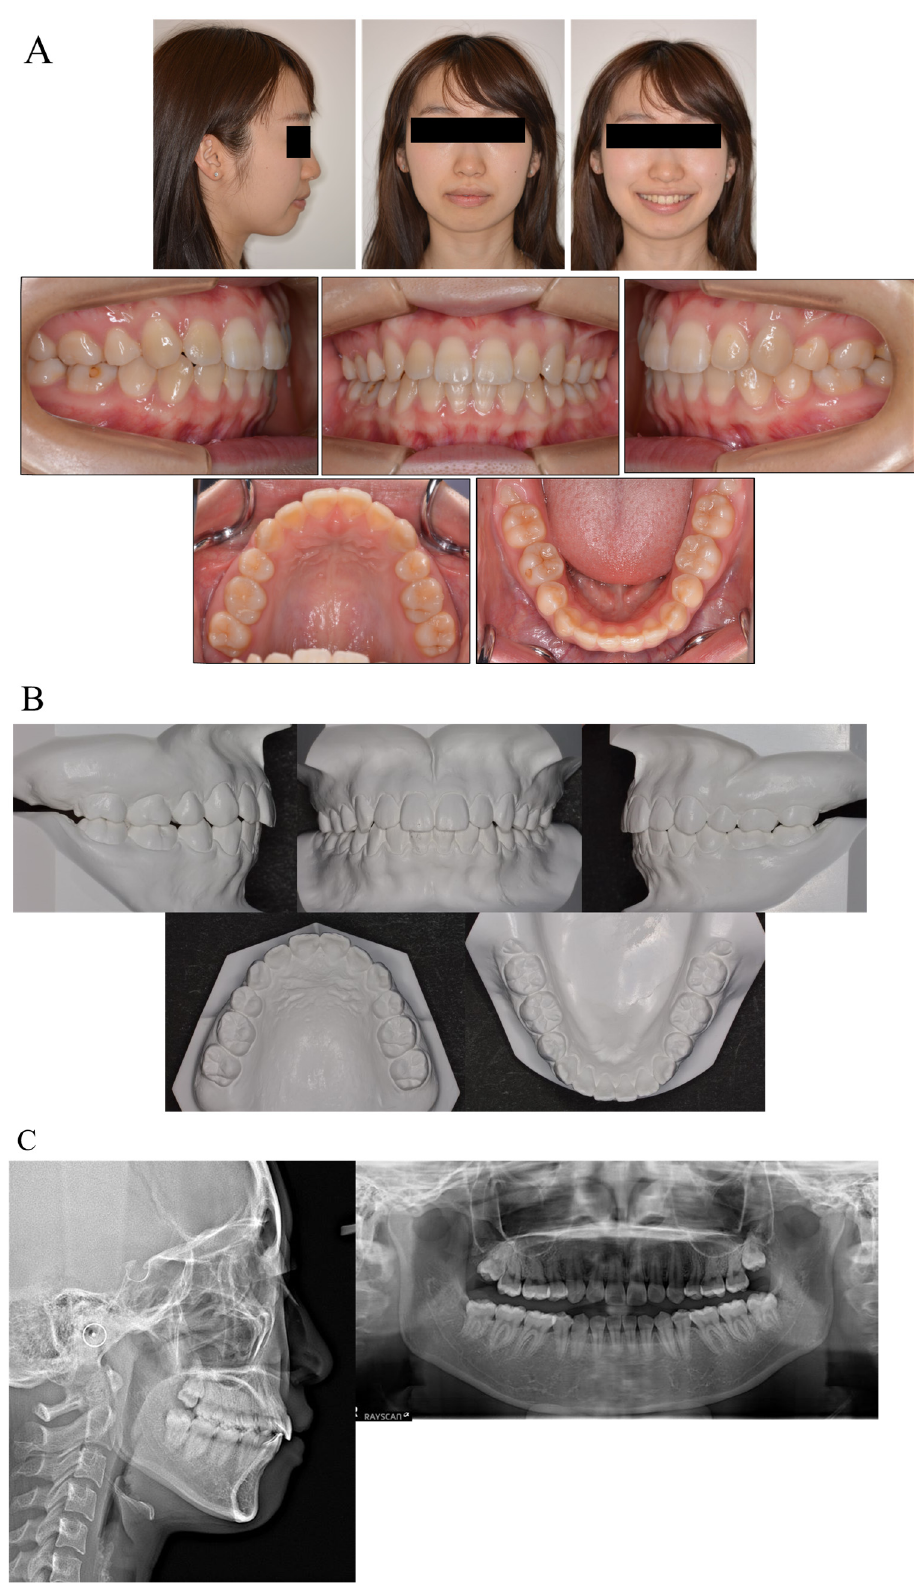
Figure 4. Facial and intraoral photograph ( A ), dental casts ( B ) and radiographs (( C ) lateral cephalo- gram; panoramic radiograph) of post-treatment at three years and six months (patient is 20 years old).